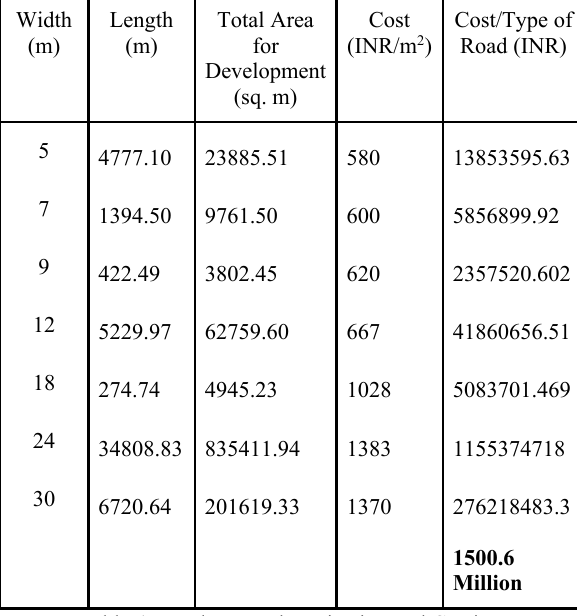
Table 4. Road Network Projection and Costing